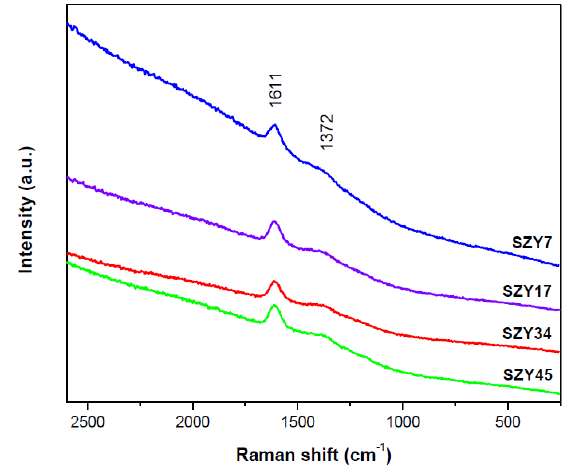
Figure 12. Raman spectra of the spent Y-type zeolites.